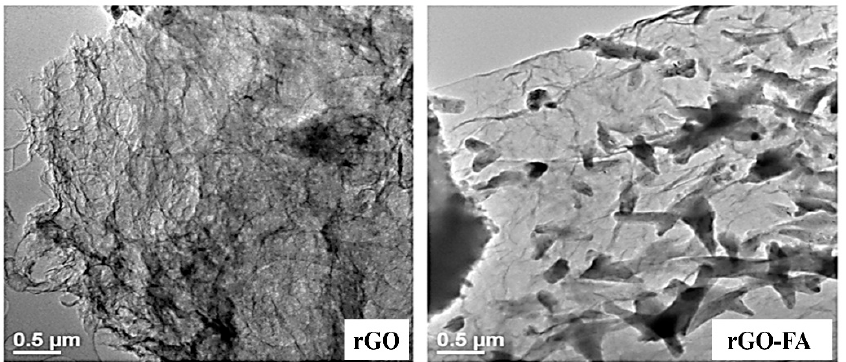
Figure 5. HRTEM images of rGO and